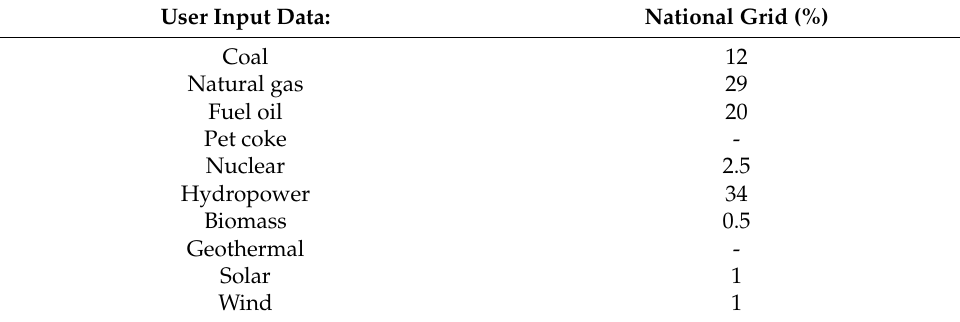
Table 5. Electricity grid mix percentage for Pakistan